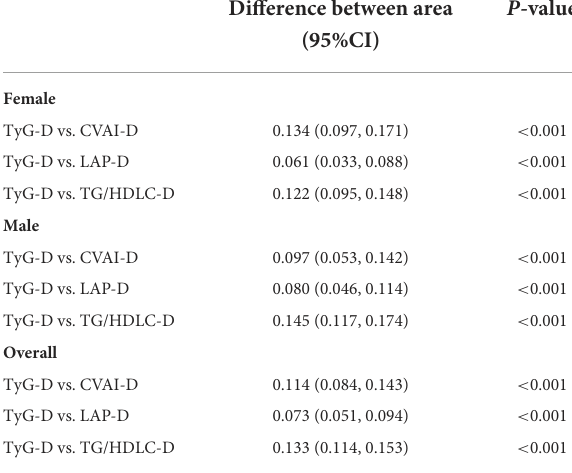
TABLE 4 Comparison of AUC values between TyG-D and other indexes by genders. Difference between